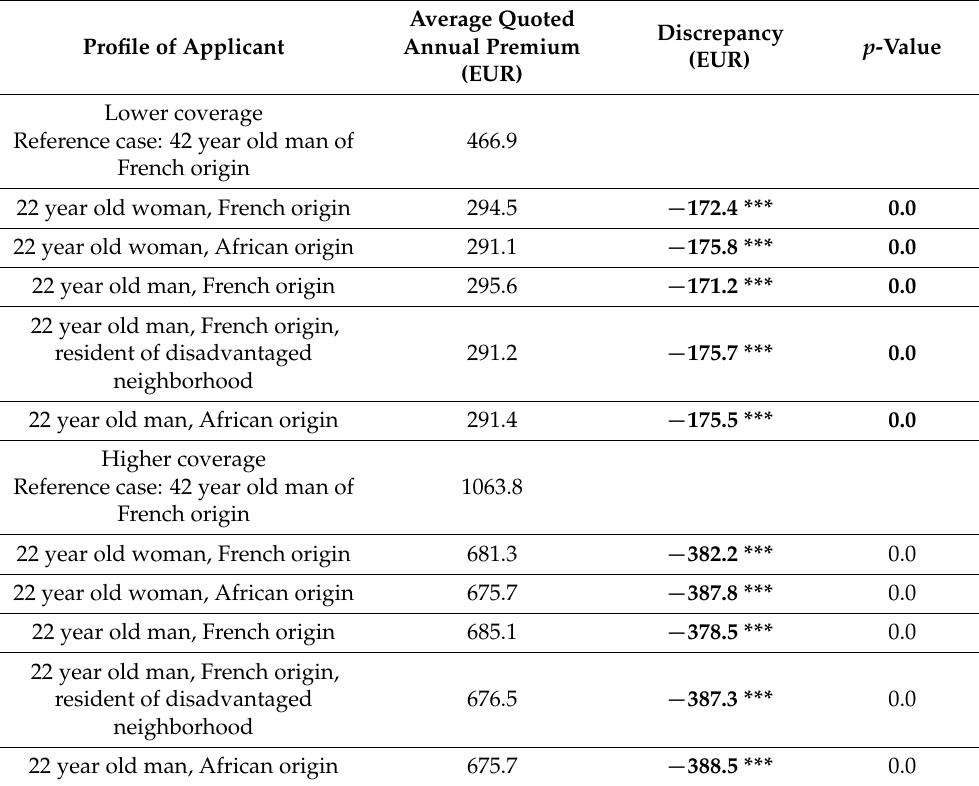
Table 7. Differences in the premiums quoted for complementary health insurance applications (reference profile: 42 year old man, French